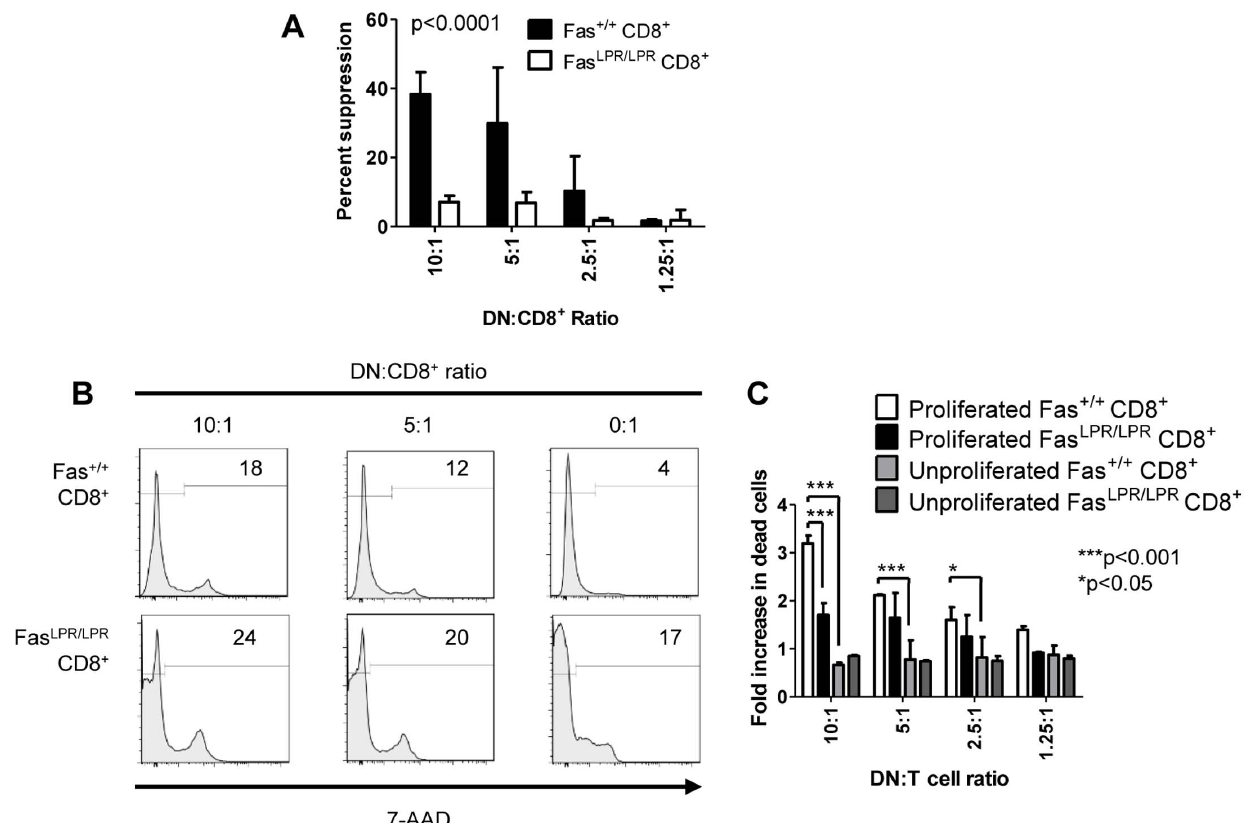
Figure 6. CD8 + T cells proliferating in response to alloantigen are selectively killed by LPR DN T cells via the Fas pathway. CD8 + T cells (10 5 /well) from B6 (Fas + / + ) or B6.LPR (Fas LPR/LPR ) were labelled with CFSE and cocultured with irradiated CB6F1 splenocytes and IL-2 for 5 days without or with LPR DN T cells in the indicated ratios. After 5 days, the cultures were stained with anti-CD8-APC and 7-AAD and analyzed by flow cytometry. A. The percentage of undivided cells (CFSE hi ) was used to determine the percent suppression at each DN:CD8 + T cell ratio. Two-way ANOVA p , 0.0001 for the effect of CD8 + T cell Fas expression. B. Representative histograms of 7-AAD staining gated on proliferated (CFSE-diluted) Fas + / + (top row) and Fas LPR/LPR (bottom row) CD8 + T cells at the indicated DN:CD8 + ratios. Numbers inside histograms are the percentages of cells falling in the 7-AAD + gate. C. The fold increase in cell death for proliferated Fas + / + (white bars), proliferated Fas LPR/LPR (black bars), unproliferated Fas + / + (light grey bars), proliferated Fas LPR/LPR (dark grey bars) CD8 + T cells is shown. Two-way ANOVA p , 0.0001; Bonferrroni post-tests ***p , 0.001 and *p , 0.05. Data are derived from two independent experiments each with duplicate wells.